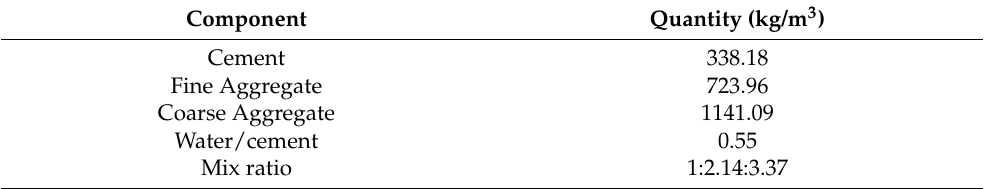
Table 5. Mix design.